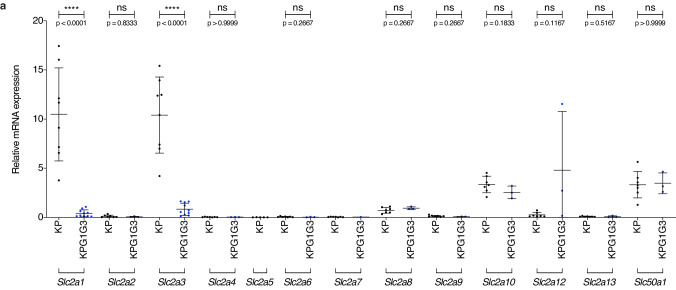
KP tumors do not express differently another glucose transporter upon dual Glut1 and Glut3 deletion.(a) Dot plots with mean ± s.d. show the relative glucose transporter mRNA expression in CD45 negative fraction from KP and KPG1G3 tumors (Slc2a1 and Slc2a3: n = 8 and 10 tumors, respectively; Slc2a2, Slc2a4, Slc2a5, Slc2a6, Slc2a7, Slc2a8, Slc2a9, Slc2a10, Slc2a12, Slc2a13 and Slc50a1: n = 7 and 3 tumors, respectively). ns: not significant by Mann-Whitney test; ****: p < 0.0001 by Mann-Whitney test